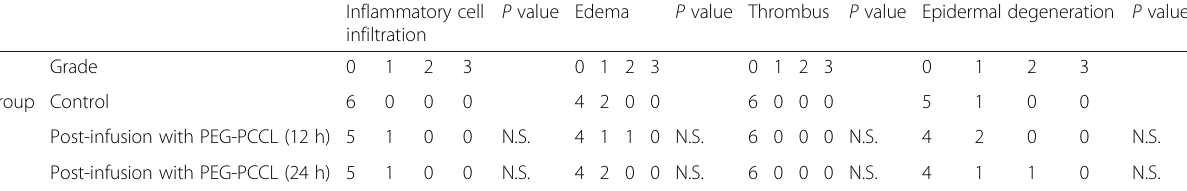
Table 1 Effect of post-infusion with PEG-PCCL on the histopathological grade in 6 rabbits at 12 and 24 h